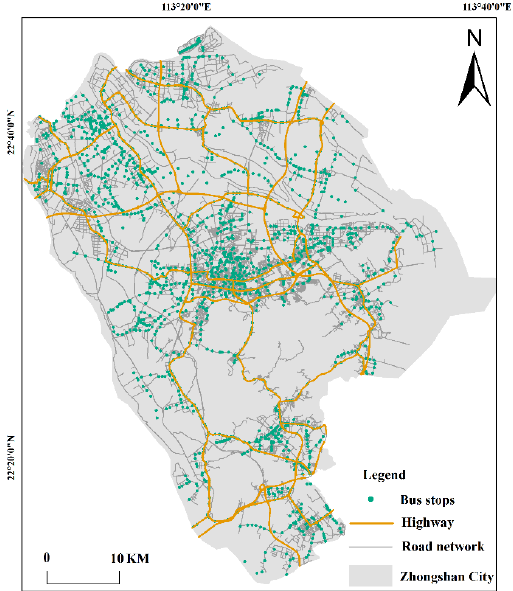
Figure 4. The public transport network in Zhongshan City.